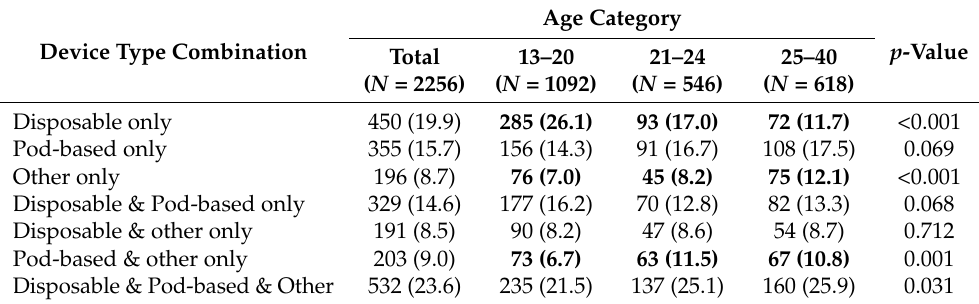
Table 3. Combinations of different e-cigarette devices used among past 30-day users, no. (%).